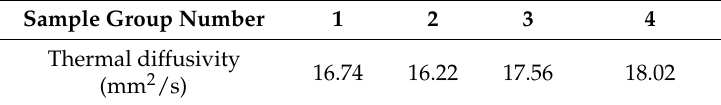
Table 2. Thermal diffusivity of WC–Co cemented carbide.